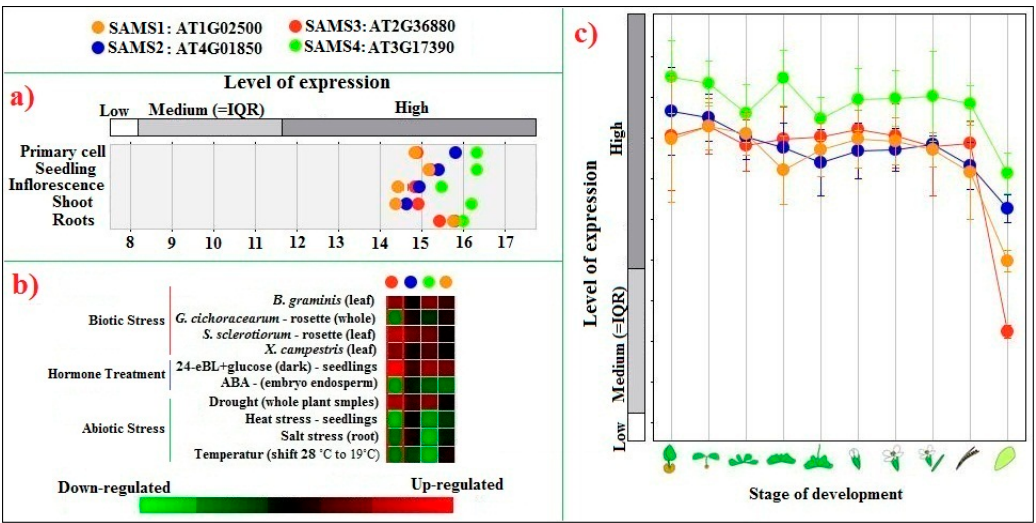
Figure 9. Expression levels of Arabidopsis SAMS genes in various tissues and organs ( a ) under different biotic and abiotic stresses and hormone treatments; ( b ) and at different development stages; ( c ) The data were obtained from Affymetrix Arabidopsis ATH1 genome array (10,615 samples) using Genevistigator [45].